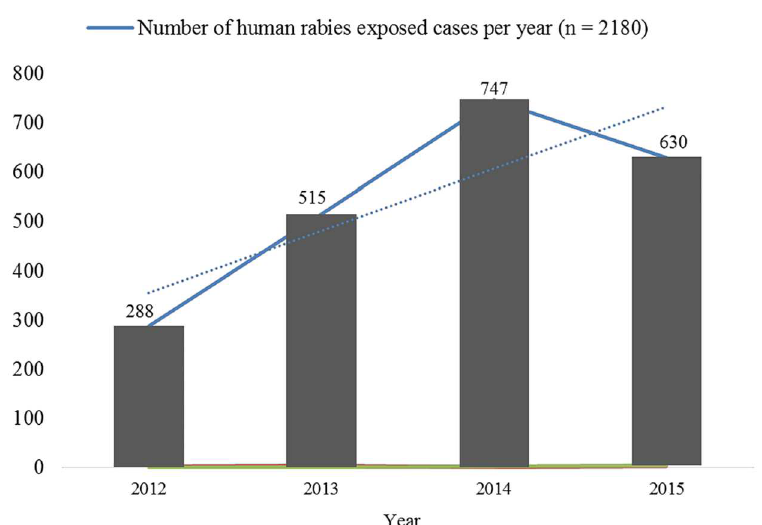
Fig 2. Trends of human rabies exposure cases across the study